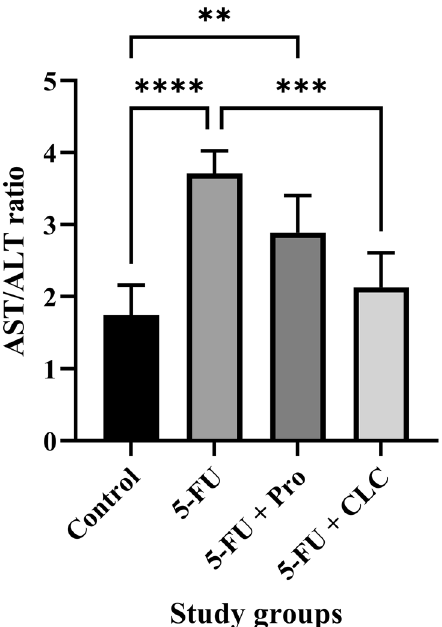
Figure 5. Effect of 5-flurouracil and propolis administration on the AST/ALT ratio of rats. Values are expressed as mean ± standard deviation (SD). Groups: Control, Normal saline; 5-FU, 5-FU 125 mg/kg; 5-FU + Pro, 5-FU 125 mg/kg + Propolis ethanolic extract 250 mg/kg/d; 5-FU + CLC, 5-FU 125 mg/kg + Colchicine 5 mg/kg/d. ** , *** , and **** indicate p < 0.01, p < 0.001, and p < 0.0001,